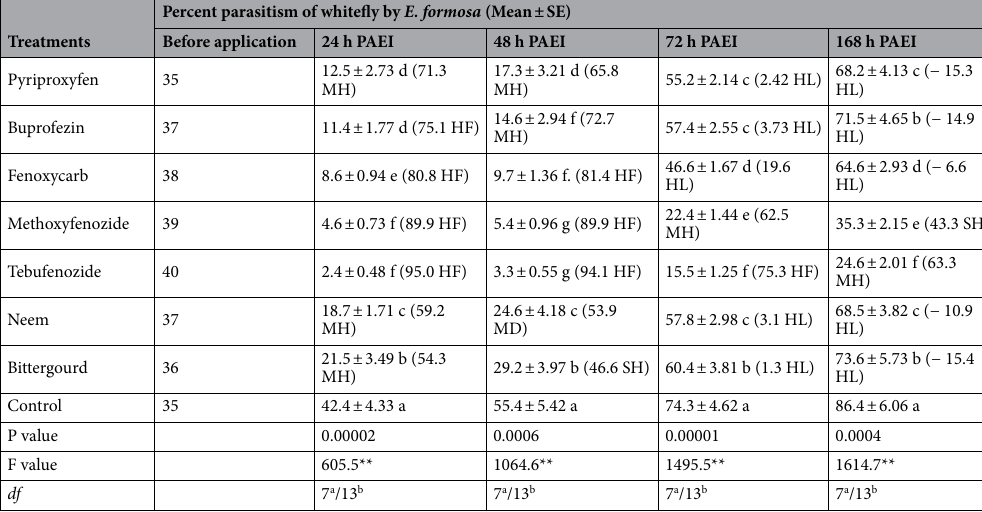
Table 2. Percent parasitism of whitefly by E. formosa at different post-treatment intervals of different insecticides on Bt cotton under field conditions. Means with the same lowercase letters are not significantly different at α = 0.05 (Tukey’s test). Positive values in parenthesis indicate the corrected percent reduction while negative values inside parenthesis indicate corrected percent increase in parasitism over control at different PAEI. HL, SH, MH and HF abbreviations inside the parenthesis indicate Harmless/Class-I, Slightly-harmful/ Class-II, Moderately-harmful/Class-III and Harmful/Class-IV insecticides, respectively). df Degree of freedom. a Degree of freedom of treatment. b Error degree of freedom. **Highly significant at probability level of 5%.